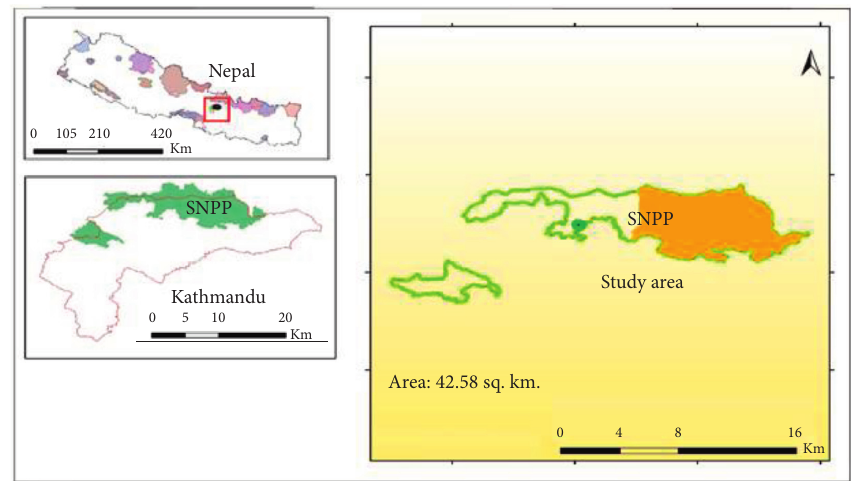
Figure 1: Study area map.